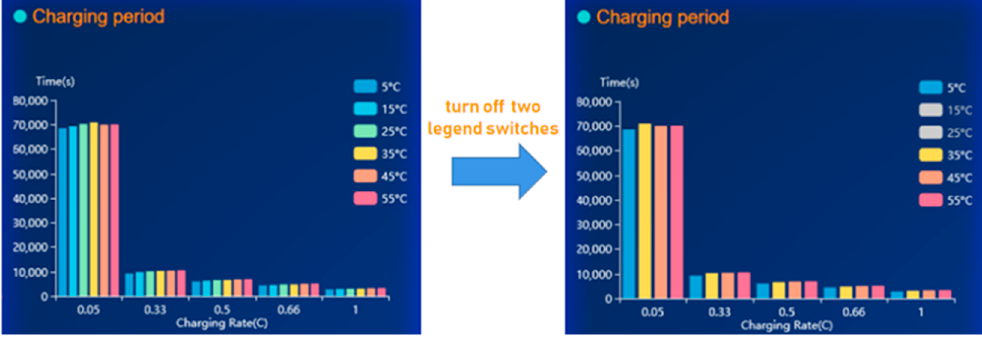
Figure 5. A histogram in tiled mode and its visualization when two of the legend switches are turned off.